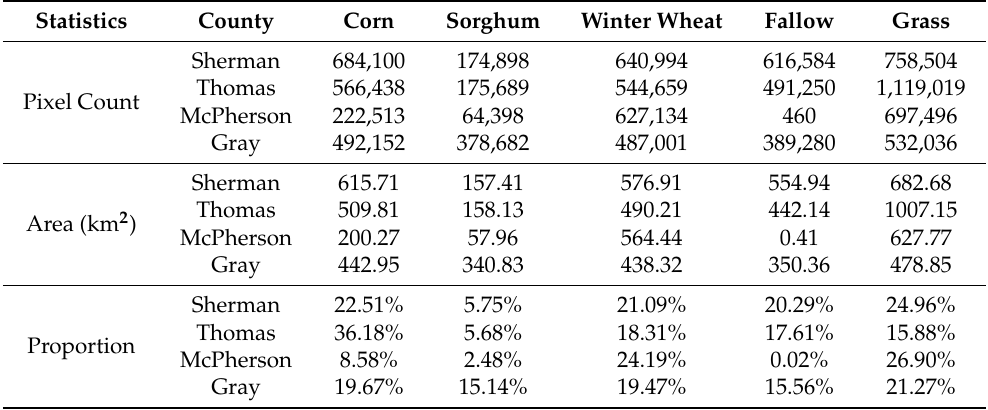
Figure 1. Reference data in study areas of Sherman, Thomas, Gray, and McPherson in Kansas, US. Table 1. Each class is expressed as an area (km 2 ), the number of pixels, and the proportion in Sherman, Thomas, Gray, and McPherson in 2017,